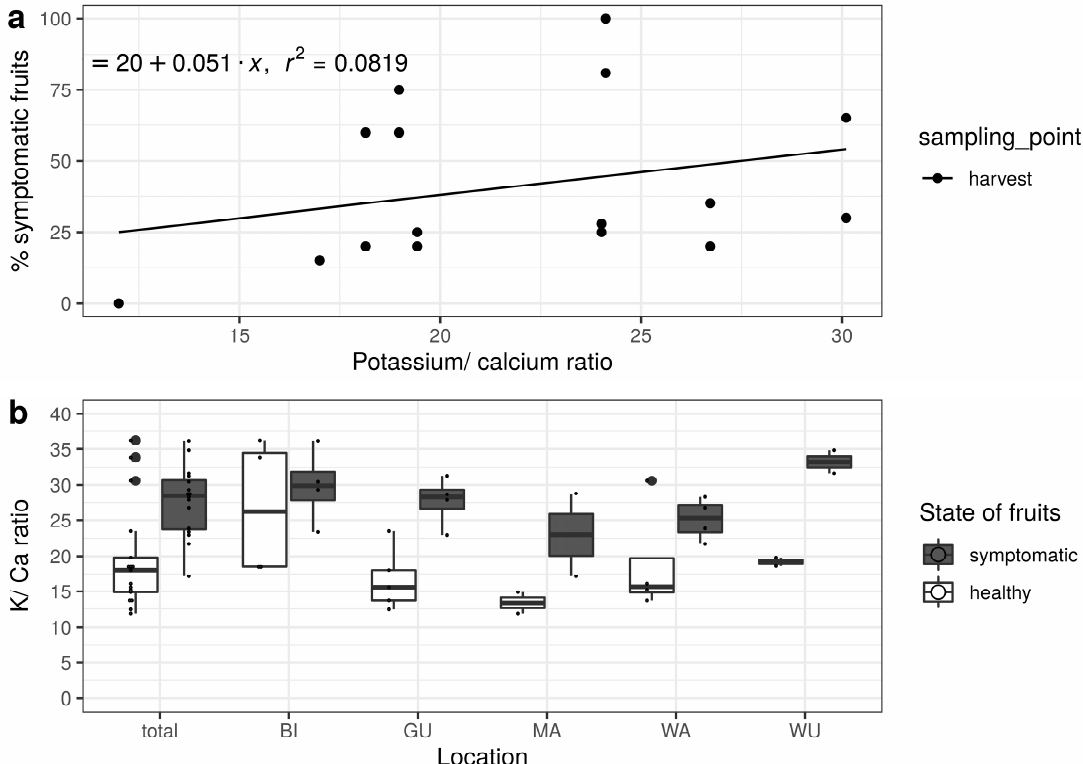
Figure 4. Potassium and calcium (K/Ca) ratios in fruits measured using AAS (atomic absorption spectroscopy) and correlations to superficial scald development. ( A ) Mean K/Ca ratio measured by AAS at harvest and percent of fruits with superficial scald at removal from storage showed a very poor correlation with r 2 = 0.0819; ( B ) K/Ca ratio in damaged and undamaged fruits after storage split by location, measured by AAS. Blidegg-Bischofszell (BI), Morges-Marcelin (MA), and Wülflingen (WU) were measured in 2016; Wädenswil (WA) in 2017 and 2018; and Güttingen (GU) in 2016, 2017, and 2018. K/Ca ratio was measured twice per plot each year, at two different storage removal dates.